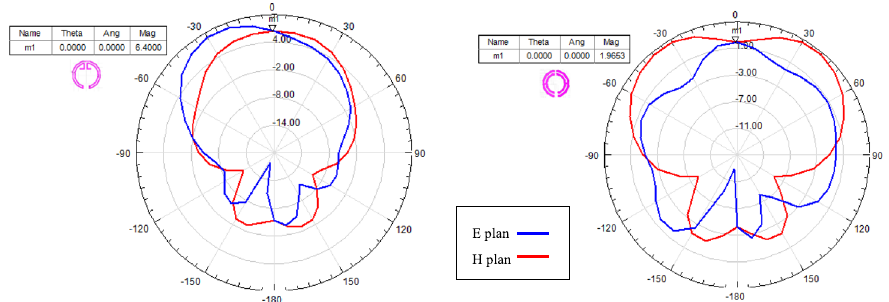
Fig. 7 Simulated radiation patterns of microstrip patch antenna loaded with D-SRR